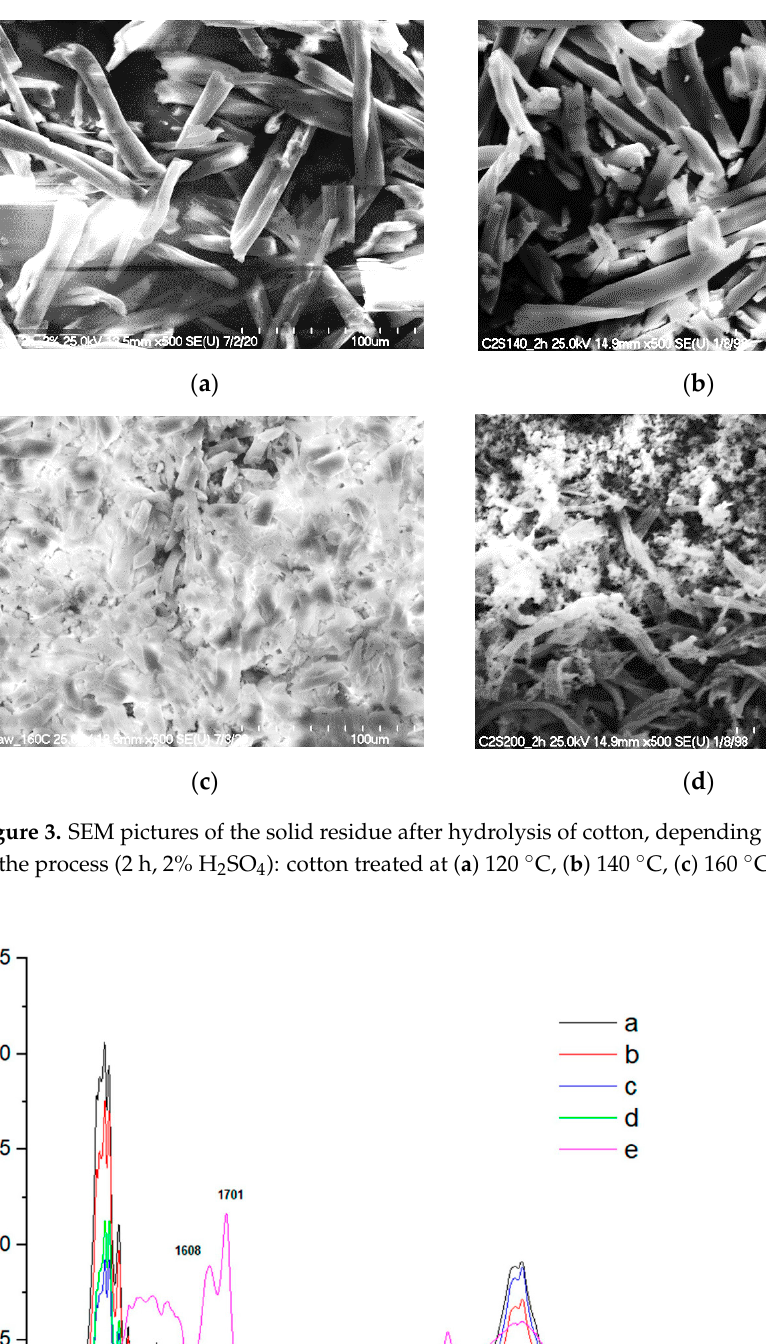
Figure 5. Raman spectra of ( a ) washed cotton and cotton treated for 2 h with 2% H 2 SO 4 at various temperatures: ( b ) 120 °C; ( c ) 140 °C; ( d ) 160 °C; ( e ) 200 °C.